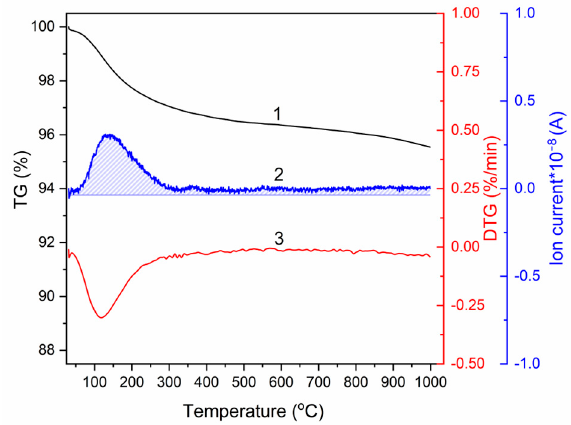
Figure 4. Thermal analysis of nano-HA: 1—thermogravimetry (TG); 2—mass spectrum indicating water release; 3—differential thermogravimetric curve (DTG).